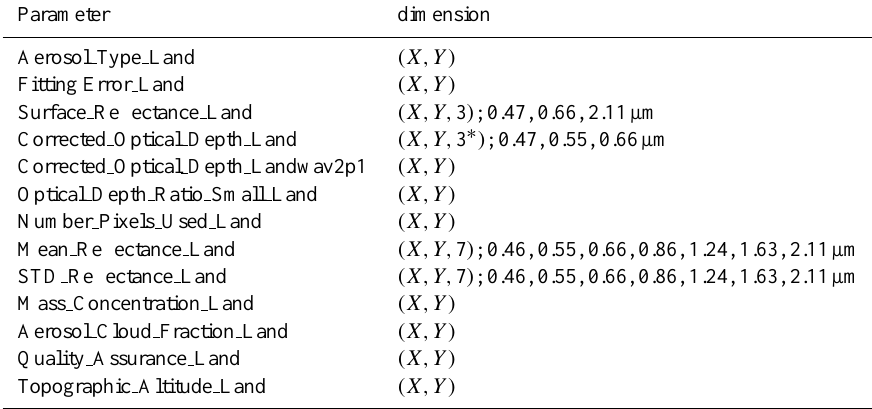
Table 3. Land parameters of the MOD/MYD04 3K file and the parameter’s dimension.